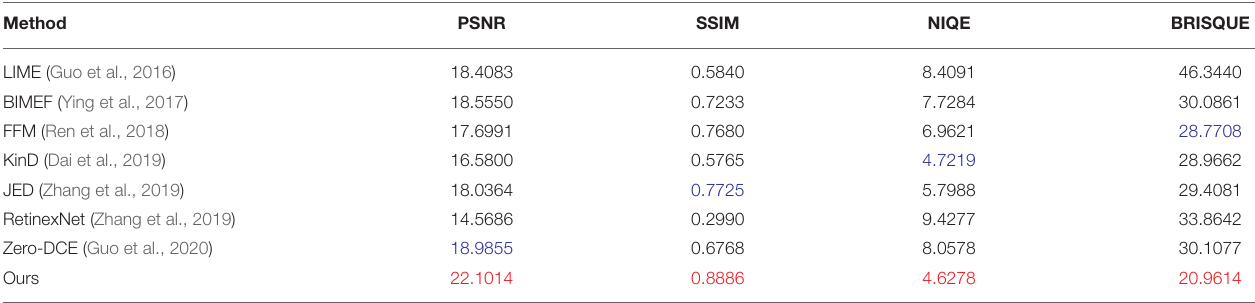
TABLE 2 | Quantitative evaluation of the low light paired dataset (LOL) dataset, with the best results marked in red and the second best results marked in blue.